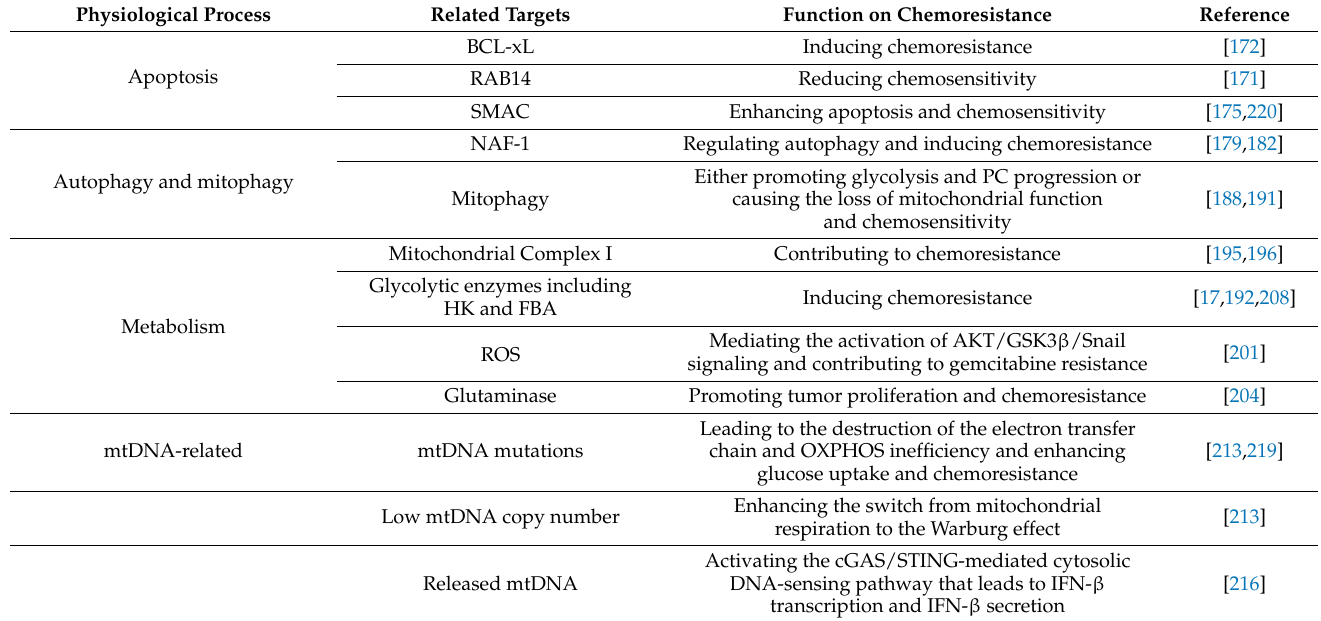
Table 1. Related pathways and mechanisms of mitochondria-associated